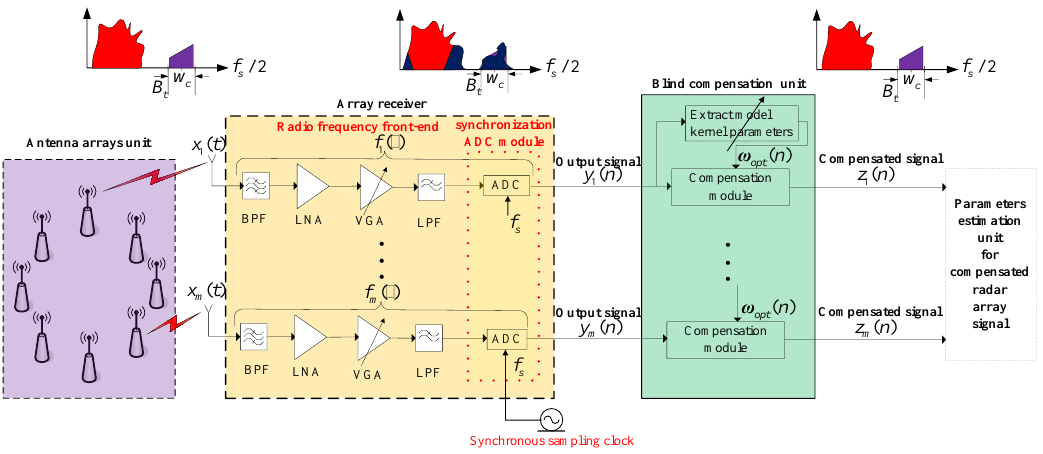
Figure 1. Block diagram of the nonlinear blind compensation processing for the array system.